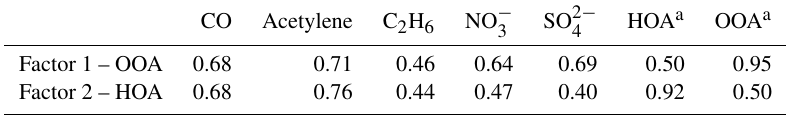
Table 4. Correlation coefficient of PMF factors with different